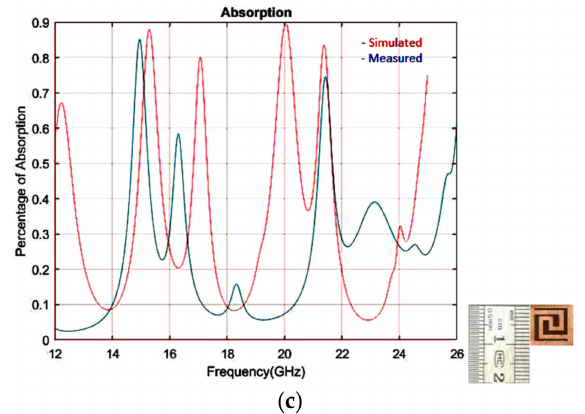
Figure 4. Simulated and measured results for FR4 substrate and 8 × 8 ground ( a ) permittivity vs. frequency graph, ( b ) permeability vs. frequency graph, ( c ) percentage of absorption vs. frequency graph.